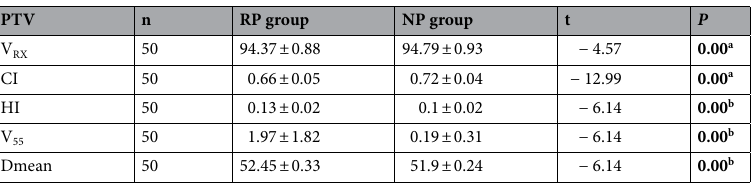
Table 1. Dosimetry comparison for the PTV of RP group and NP group (mean ± SD). *a = Paired t test, *b = Nonparametric Wilcoxon test, P < 0.05. Bold values indicates that the difference is statistically significant ( P